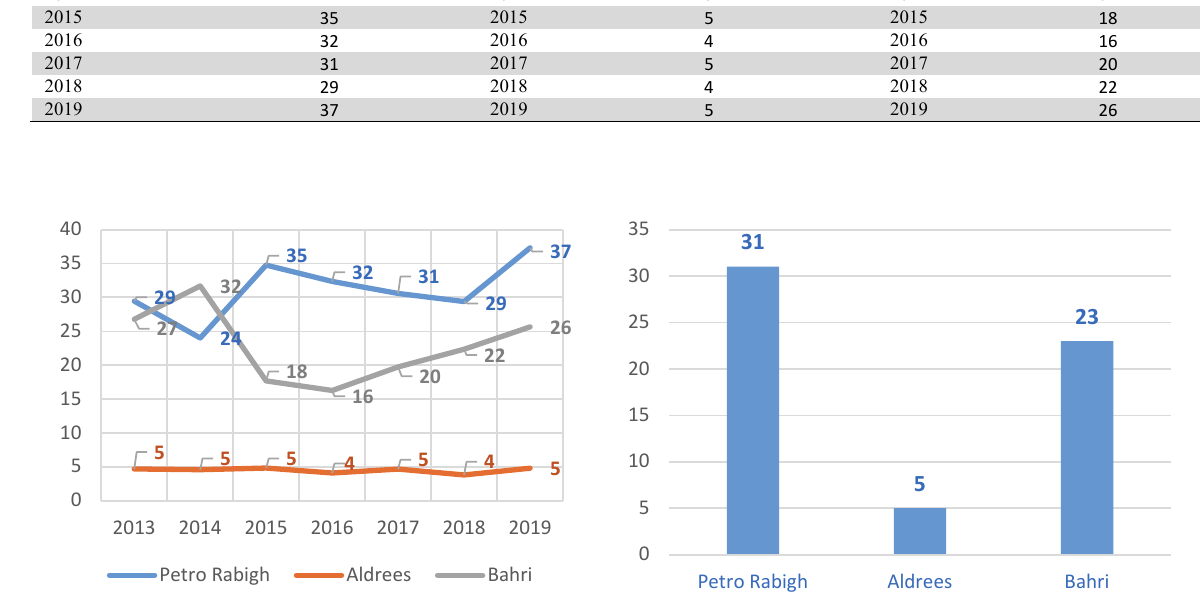
Fig. 1. The trend of DIO between 2013 and 2019 Fig. 2. DIO Mean for the period